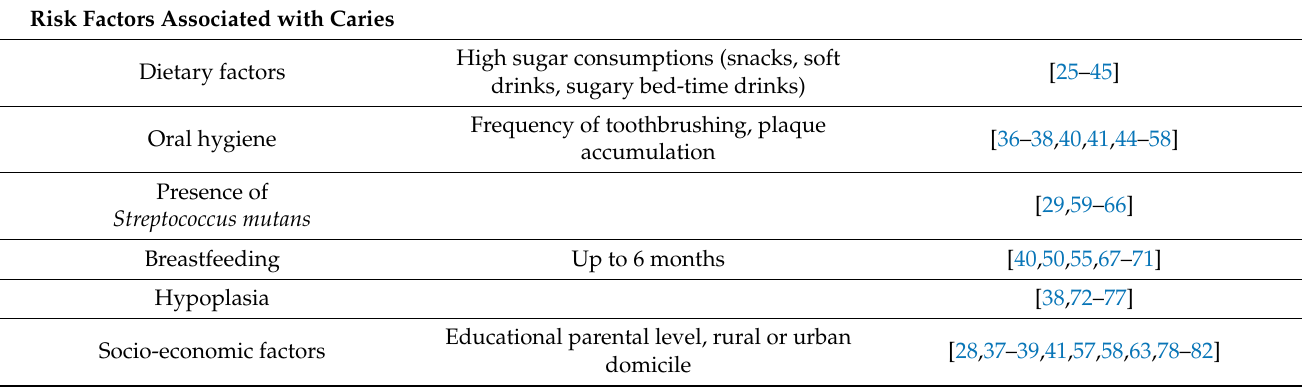
Table 2. Main risk factors involved in children’s caries.